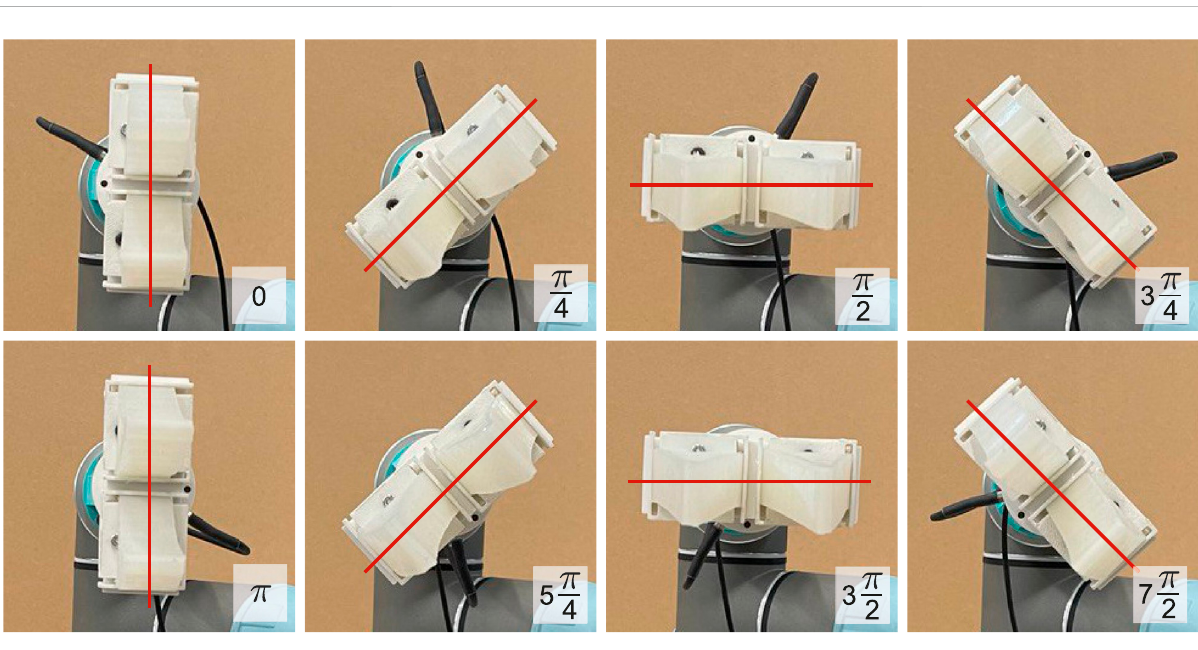
FIGURE 6 Eight roll angles of the gripper used for data collection. The angular displacement between each neighboring pair orientation is 45 ° .